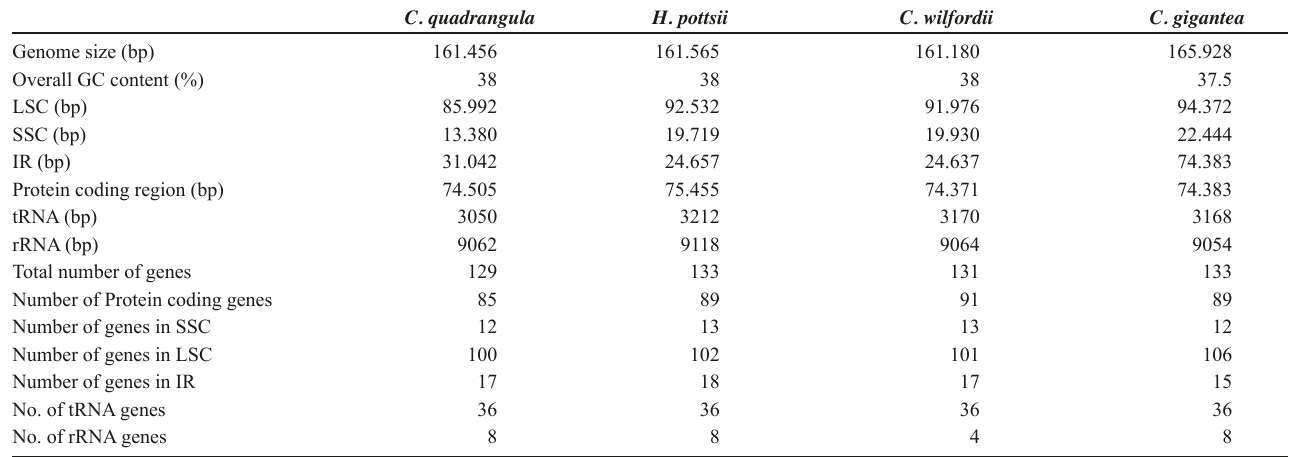
Tab. 2: Summary of the complete cp genome features of C. quadrangula, H. pottsii, C. wilfordii , and C. gigantea.